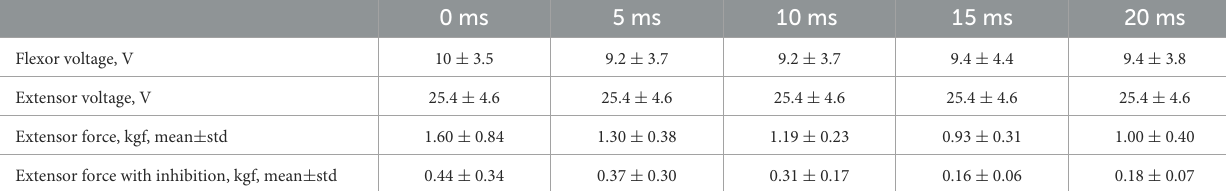
TABLE 2 Experimental results for stimulation of the extensor muscle and the